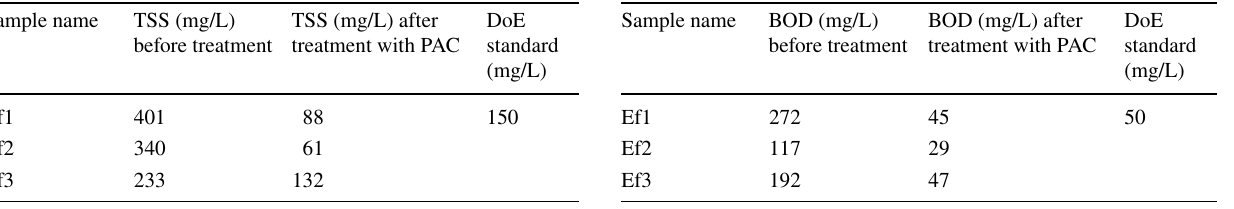
Table 4 Total suspended solids (TSS) of textile effluents Table 5 Biological oxygen demand (BOD) of textile